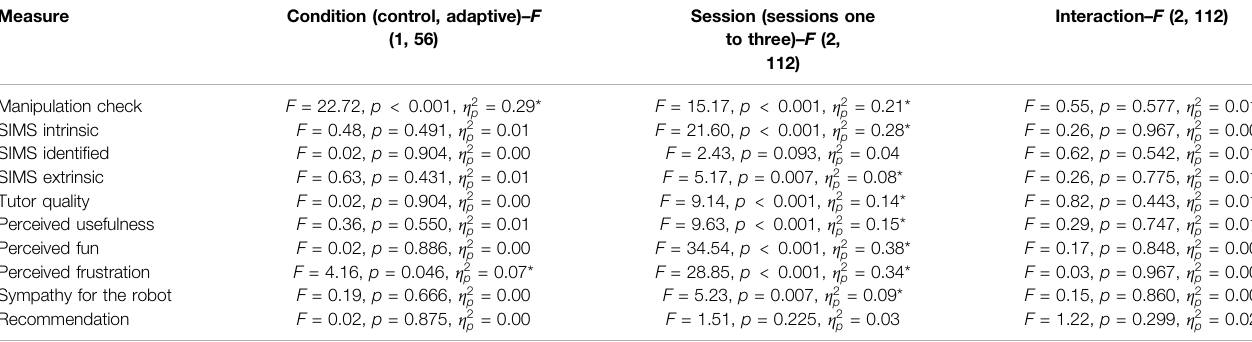
TABLE 4 | Results of 2 × 3 mixed ANOVAs for selected measures. * indicates signi fi cance. Measure Condition (control, adaptive) – F (1,